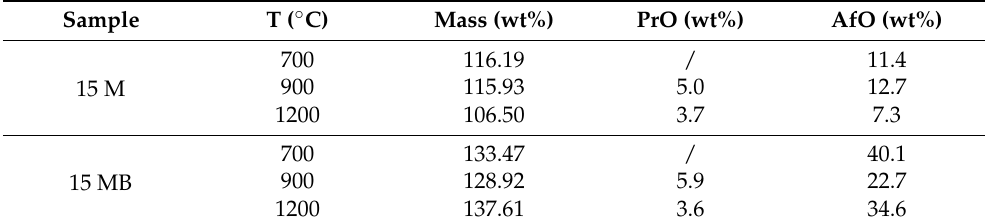
Table 2. Moisture stability of 15 M and 15 MB ceramic products (“PrO” means “prior O” and “AfO” means “after